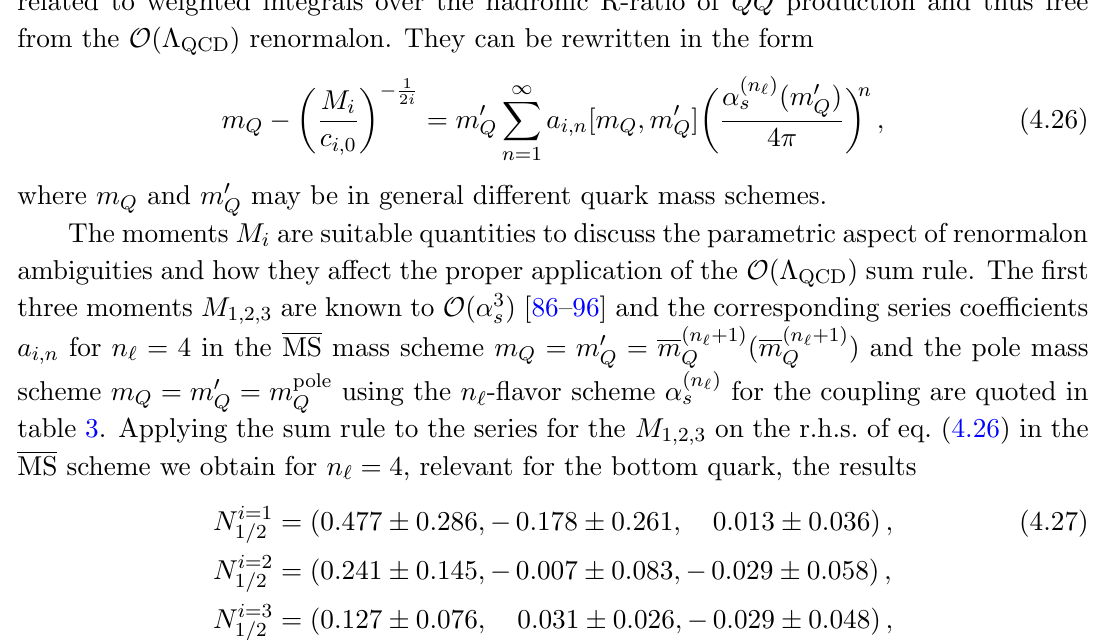
on the r.h.s. of eq. (4.26) in the 1 ; 2 ; 3 = 4, relevant for the bottom quark, the ‘